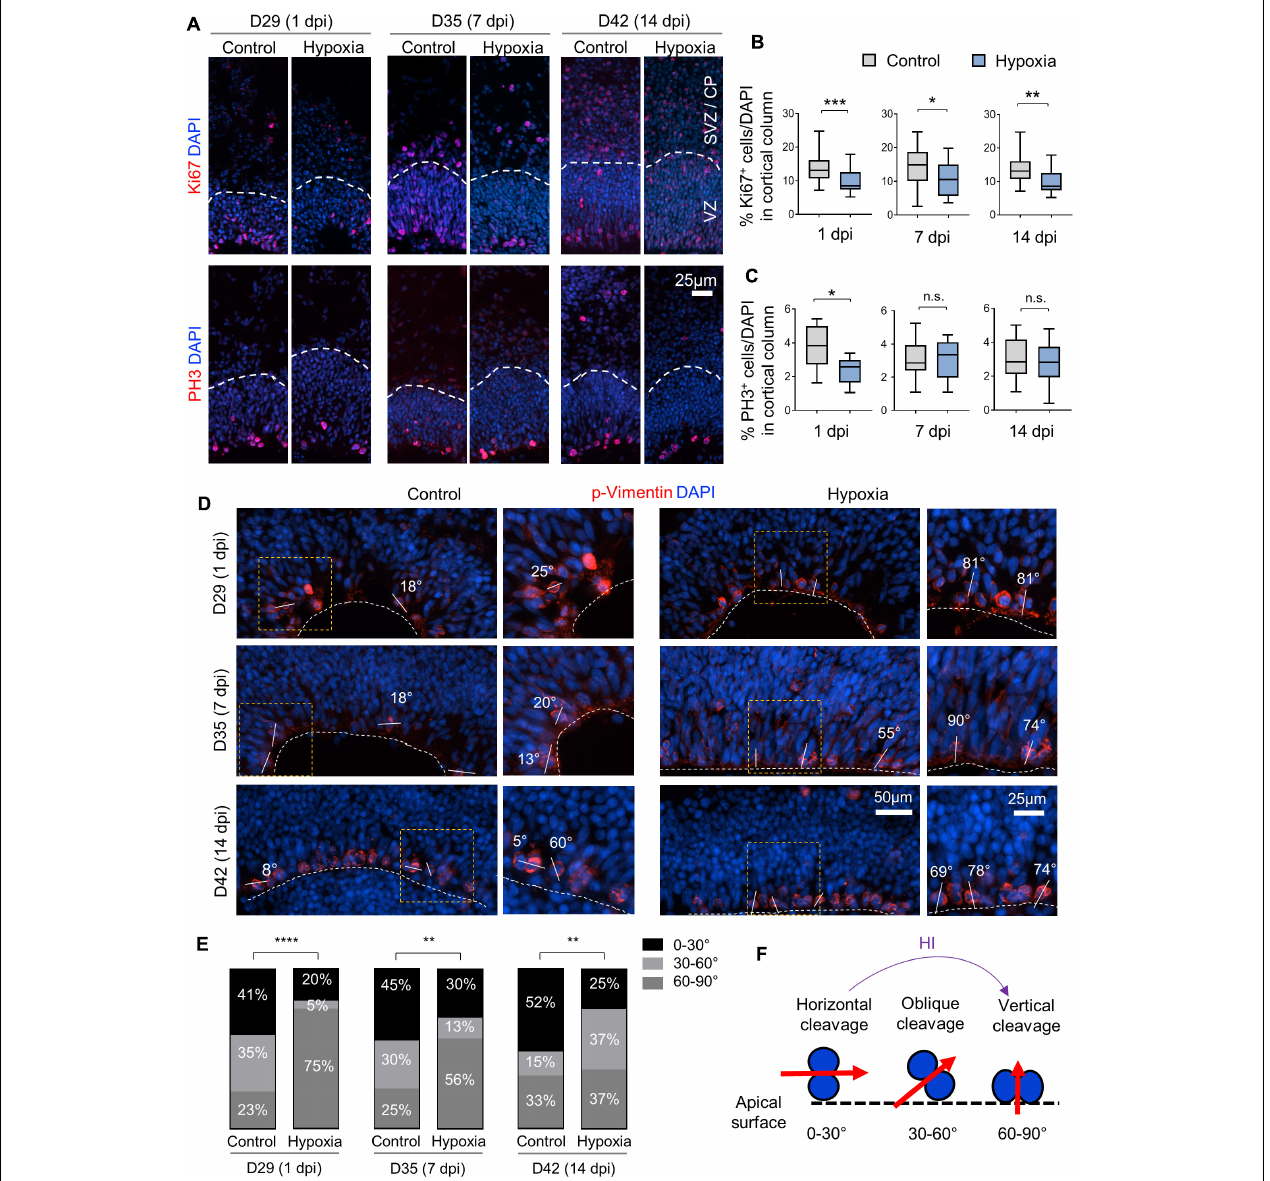
FIGURE 4 | Hypoxic injury reduces proliferation and induces a shift of cell division mode in cerebral organoids. (A) IF images for Ki67 and G2/M mitotic marker PH3. White dashed lines delineate VZ and SVZ/CP-like layers in 100 × 300 µ m cortical columns. (B,C) Quantifications of Ki67 + cells (B) and PH3 + cells (C) in cortical columns. Student’s t test, n = 9 organoids. (D) IF images of phospho-Vimentin at apical ventricular surface. Dashed white lines mark the apical surface of ventricle structures. Solid white lines and number labels indicate cleavage plane angle of dividing cells relative to apical surface. High magnification images of boxed area are shown in right panels. (E) Quantifications of the prevalence of dividing cells with vertical (defined as 60–90 ◦ relative to apical surface), oblique (30–60 ◦ ), and horizontal (0–30 ◦ ) cleavage plane at apical ventricular surface of cerebral organoids at indicated time points in control or after HI. Chi-square test, n = 20–25 cells quantified per condition. (F) Schematic model of a shift of cleavage plane from horizontal to vertical in proliferating cells at apical ventricular surface induced by transient HI. ∗ p < 0.05; ∗∗ p < 0.01; ∗∗∗ p < 0.001; ∗∗∗∗ p < 0.0001; n.s., not-statistically